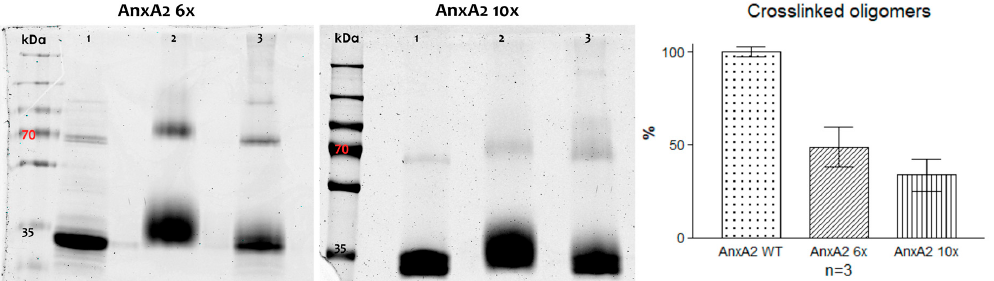
Figure 5. Chemical crosslinking of alkylated AnxA2 mutant proteins. Left, SDS-PAGE of crosslinking reactions involving AnxA2 6x and 10x. Each AnxA2 derivative was subjected to chemical crosslinking in the presence or absence of Ca 2 + and LUVs. Lanes 1: Controls #1 (AnxA2 + Ca 2 + ); lanes 2: Controls #2 (AnxA2 + LUVs + EGTA + Biotin 3xNHS X-Linker); lanes 3: Ca 2 + / membrane sample (AnxA2 + LUVs + Ca 2 + + Biotin 3xNHS X-Linker). Right, quantification of crosslinked oligomer bands for each AnxA2 derivative (calculated in relation to the respective monomer band, see Materials and Methods). Given is the relative percentage of these oligomer bands compared to those obtained for the wild-type protein analyzed in a parallel reaction. Three independent crosslinking reactions were analyzed for each protein species and the standard error of means is